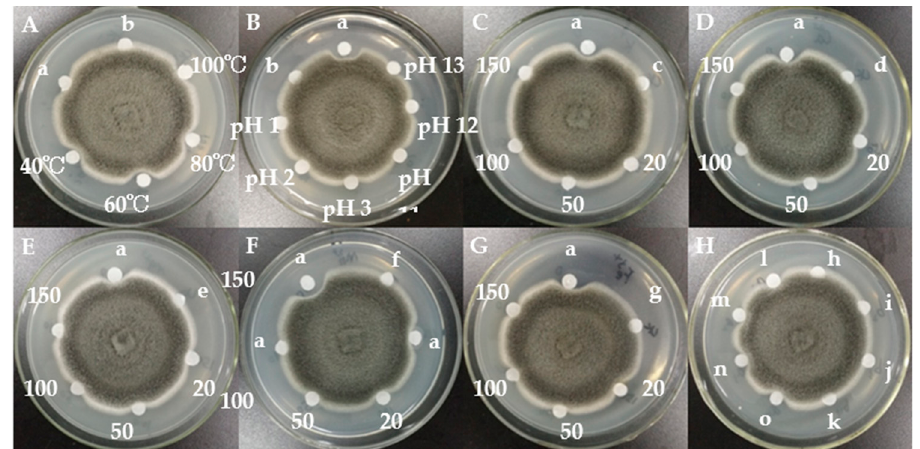
Figure 4. Effects of heat, acid-base, metal ions, and organic solvents on antifungal activity of BGAP: ( A ) heat treatment; ( B ) acid-base treatment; ( C ) treatment with K + ions; ( D ) treatment with Ca 2+ ions; ( E ) treatment